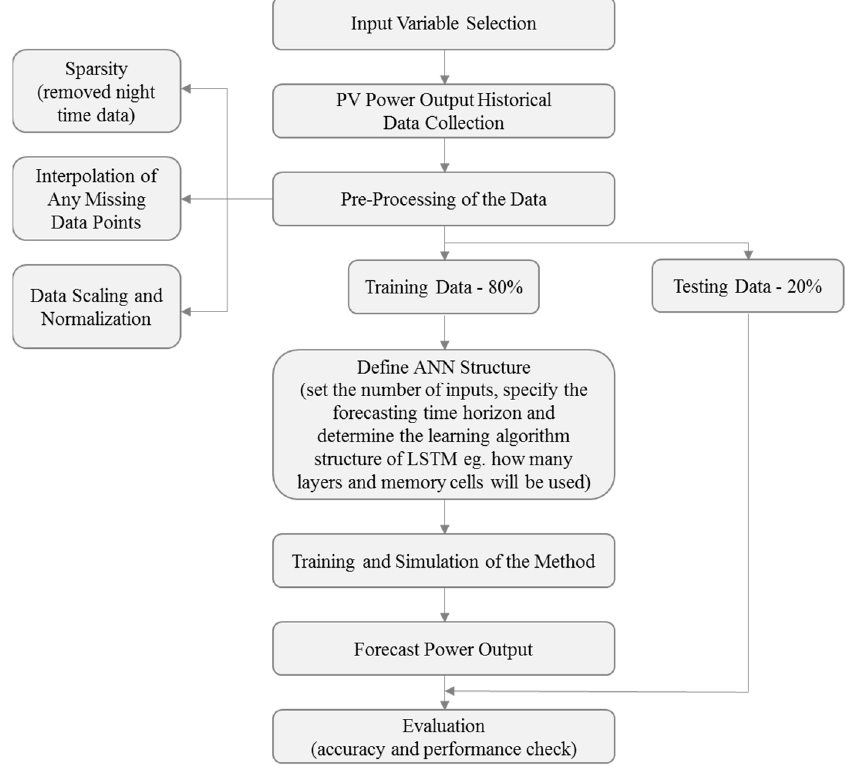
Figure 2. Flowchart of the proposed photovoltaic (PV) power forecasting method.